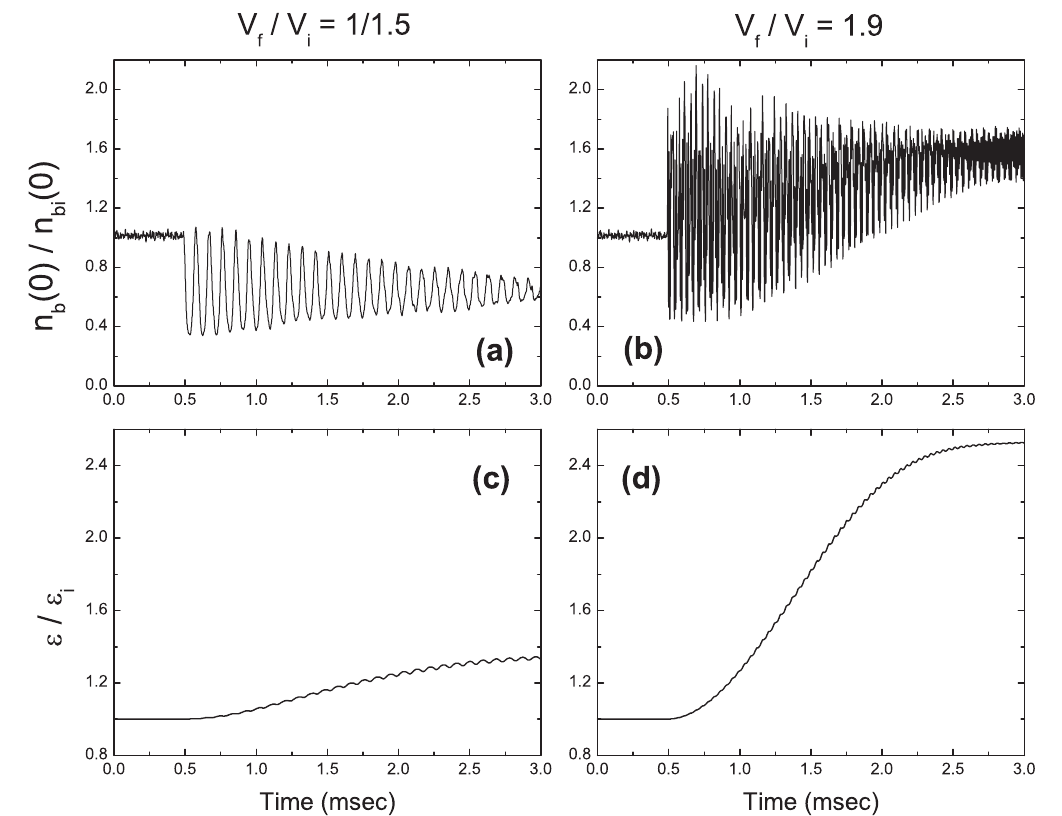
FIG. 11. 2D WARP simulations for an alternating-gradient quadrupole lattice. The evolution of the normalized on-axis density (cid:5) 0 (cid:6) =n (cid:5) 0 (cid:6) and normalized transverse emittance (cid:2)=(cid:2) n b bi f (cid:2) 60 kH z . Frames (a) and (c) correspond to the case with V (cid:2) 1 : 9 V =V f i